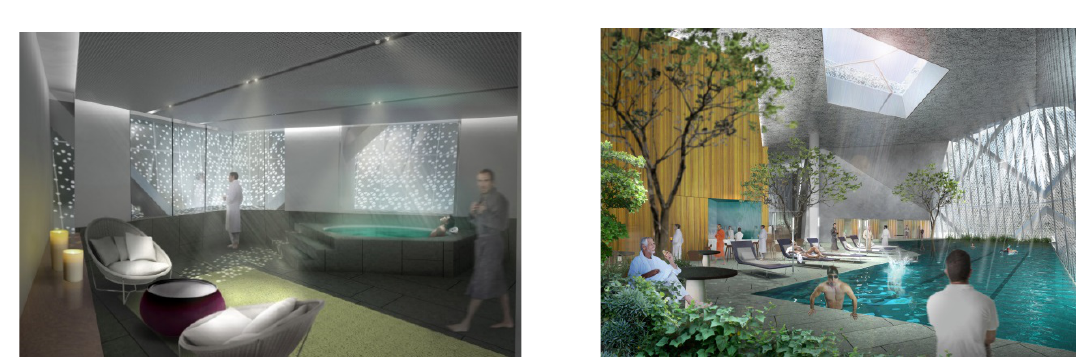
Fig 8(d) The mock-up titanium screening façade opening and closing like a camera lens due to light